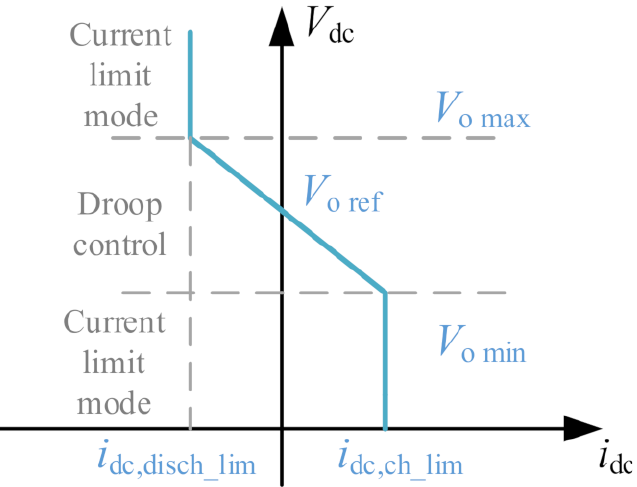
Figure 2. The traditional U-I droop